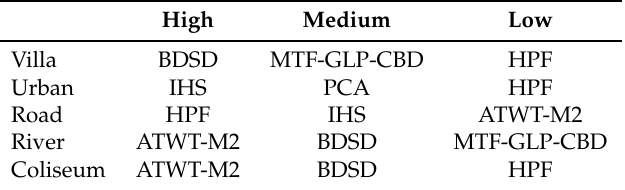
Table 15. Clustering of pan-sharpening algorithms applied to IKONOS Roma Villa, Urban, Road, River, and Coliseum scenes’ data into high, medium, and low performance. Input data for clustering are the full-resolution index Q QNR in Tables 9–13.